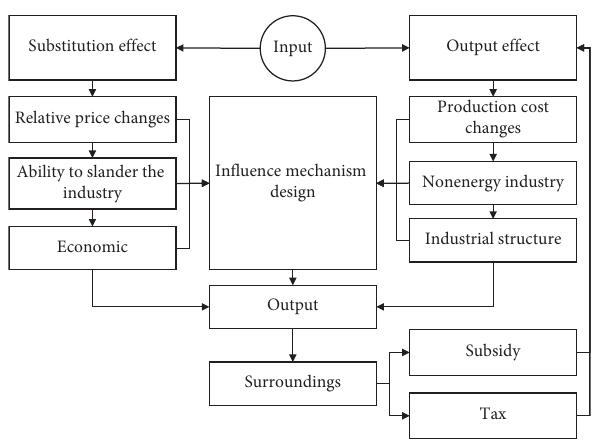
Figure 5: Influence mechanism